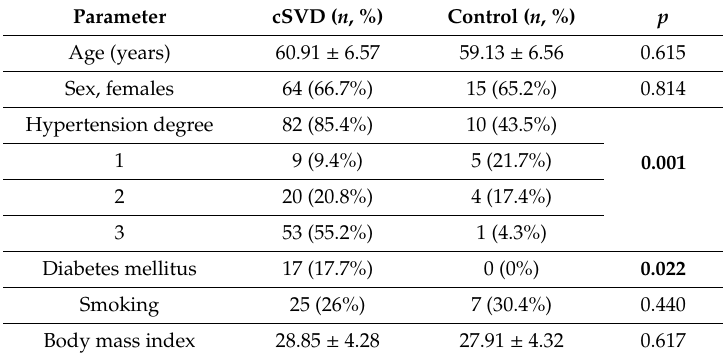
The bold text indicates statistically significant di ff